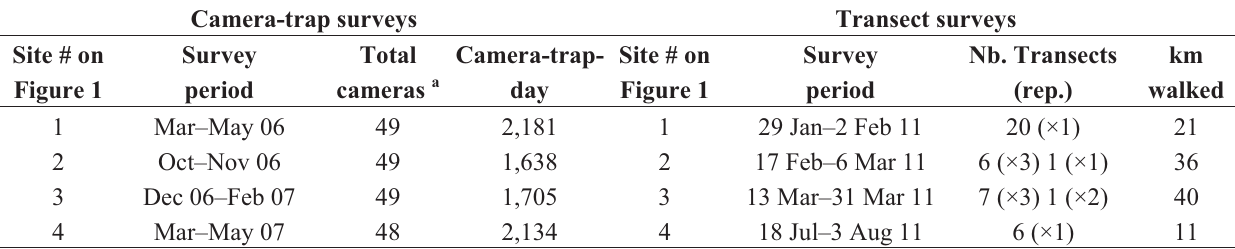
Table 1. Details of camera-trapping and transect survey effort in Nakai Nam Theun NPA from 2006 to 2012. Survey Total Camera-trap- Site # on Figure 1 period cameras a day Figure 1